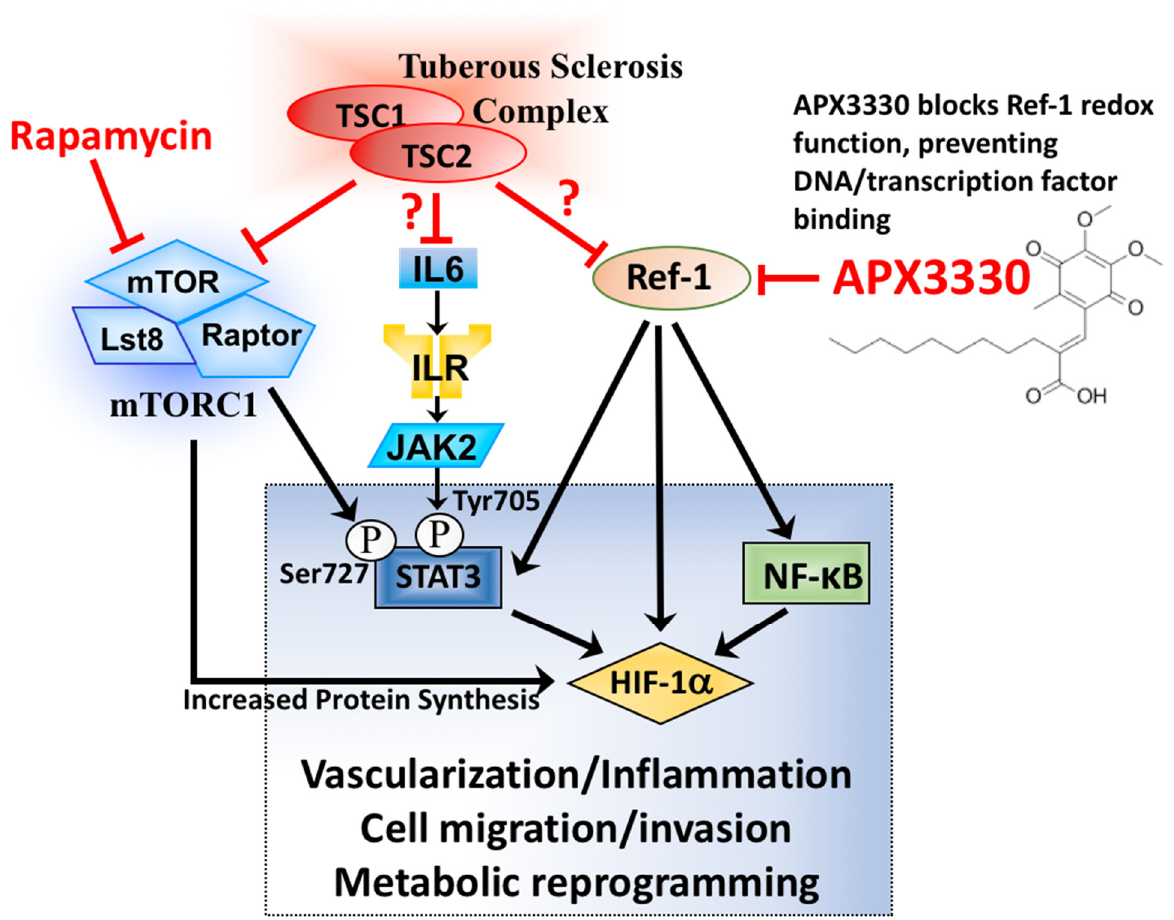
Figure 3. Diagram depicting Ref-1 redox signaling through STAT3, NF- κ B, and HIF-1 α , a possible drug target for TSC. Multiple signaling inputs from TSC1/TSC2 towards STAT3 and HIF-1 α are shown. STAT3, NF- κ B, and HIF-1 α function as a transcriptional node that orchestrates vascularization, inflammation, cell migration/invasion, and metabolic reprogramming. APX3330 blocks Ref-1 ′ s redox function to prevent the interaction of these transcription factors with DNA.